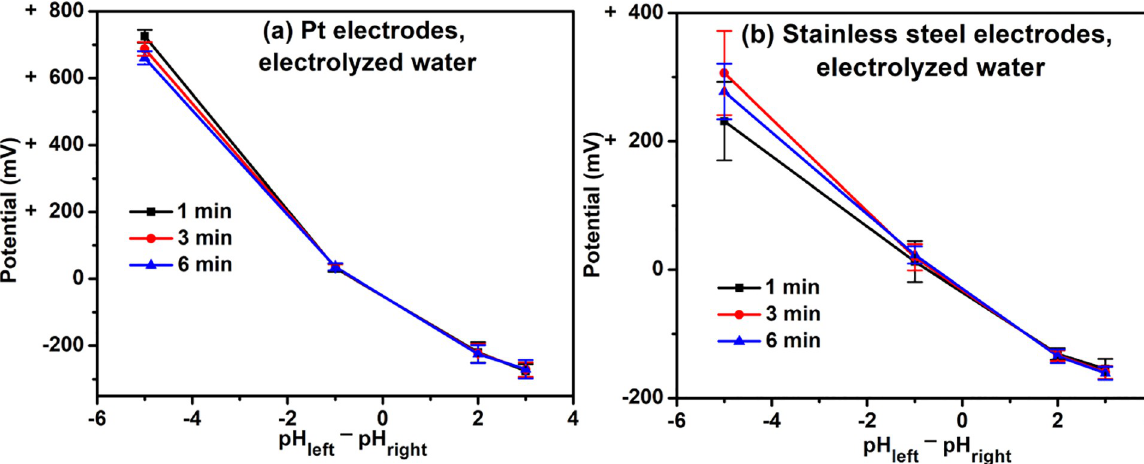
Fig 2. Potential difference between solutions produced by a water electrolyzer. Solutions in the right beaker (connected to the negative terminal of the voltmeter, Fig 1 ) were kept at pH 7, while solutions with pH 2, 6, 9, or 10 were placed in the left beaker. The pH left − pH right indicates the pH value of the solution in the left beaker minus the pH value of the solution in the right beaker. For example, when the pH of the solution in the left beaker was 9, the pH left − pH right value would be 2 (i.e., 9 minus